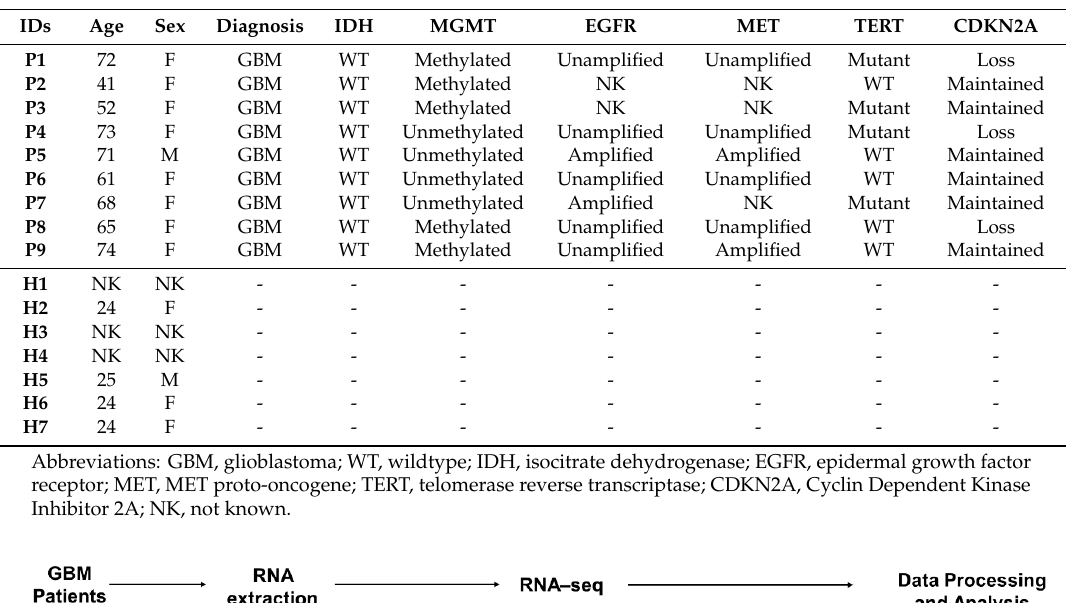
Table 1. Demographics of Glioblastoma Multiforme (GBM) patients and healthy control cohorts.